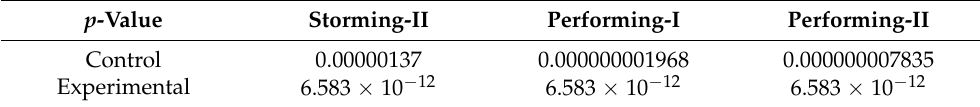
Table 7. Shapiro–Wilk test for experimental and control groups. p -Value Storming-II